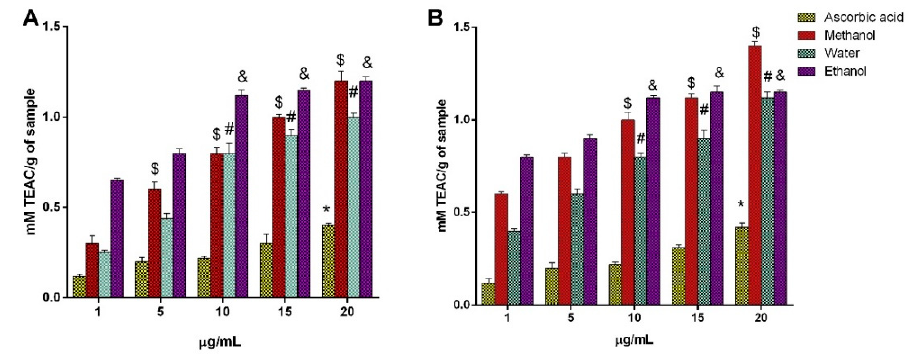
Figure 5. Ferric-reducing antioxidant power (FRAP) assay: ( A ) Artocarpus heterophyllus Lam. flower extracts, ( B ) Artocarpus lakoocha Roxb. flower extracts. All measurements were performed in triplicate. Data are shown as the mean ± standard deviation, and one-way ANOVA with a Newman–Keuls post-test was used for statistical significance; * p < 0.05 vs. 1 µ g / mL ascorbic acid; $ p < 0.05 vs. 1 µ g / mL methanol extract; # p < 0.05 vs. 1 µ g / mL water extract; & p < 0.05 vs. 1 µ g / mL ethanol extract.